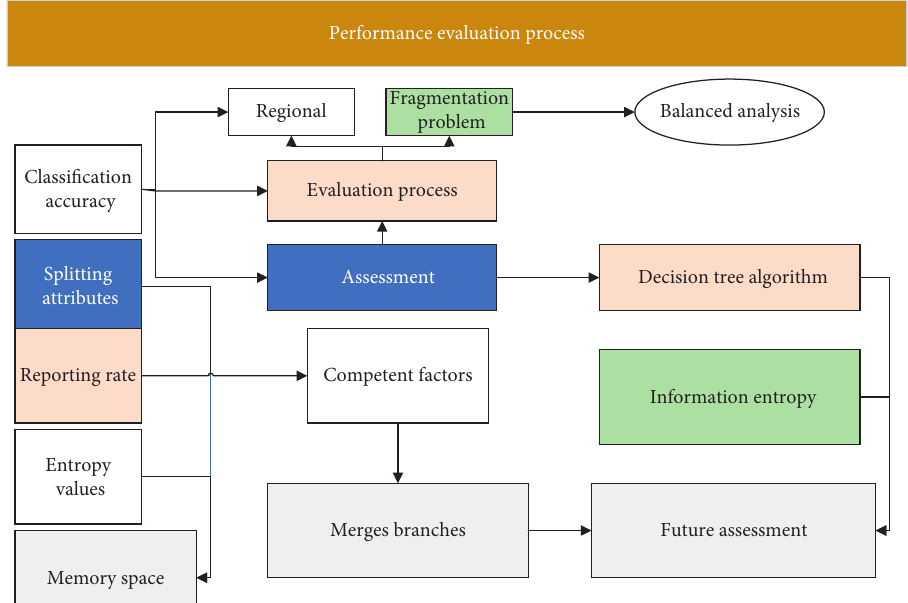
Figure 3: Performance evaluation process